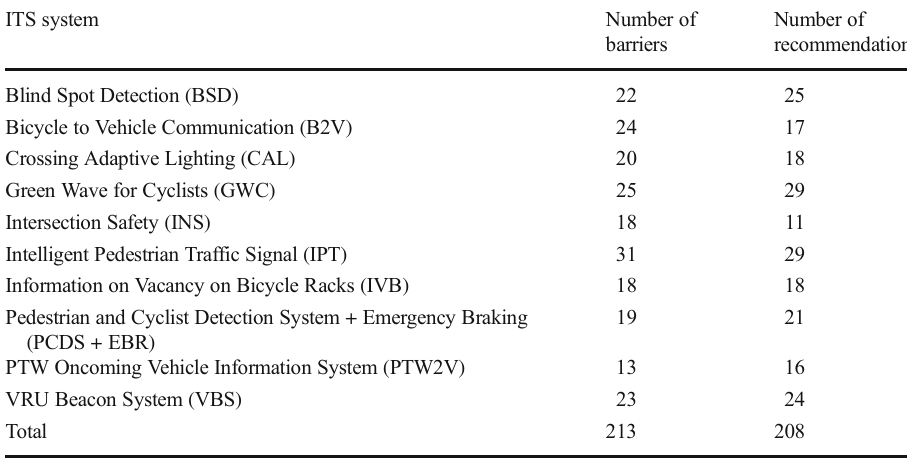
Table 5 Number of barriers and recommendations identified by system